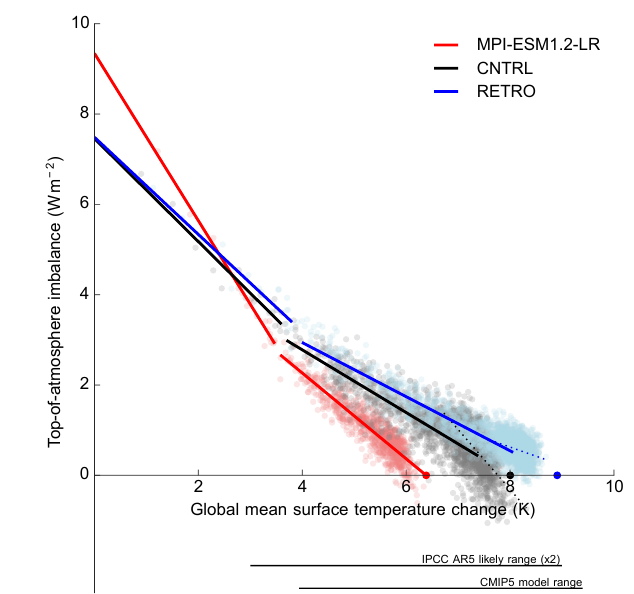
Figure C1. Surface temperature change versus top-of-atmosphere energy imbalance for RETROx4 and CNTRLx4 each run for 2500 years following an abrupt quadrupling of atmospheric CO 2 . Small dots are annual means. For comparison, a 1000-year run with MPI-ESM1.2-LR, i.e., a higher-resolution version than CNTRL, is shown. The lines are linear regressions over years 1–20 and 21– 1000, respectively, and the solid dots on the x axis shows the linear extrapolation to stationarity based on the year 21–1000 regressions. Also shown for CNTRLx4 and RETROx4 as dotted lines are the regressions for years 1001–2500. The lines in the lower part of the figure show the IPCC AR5 assessed likely ( p > 0 . 66) range as well as the range of responses found in CMIP5 climate models.